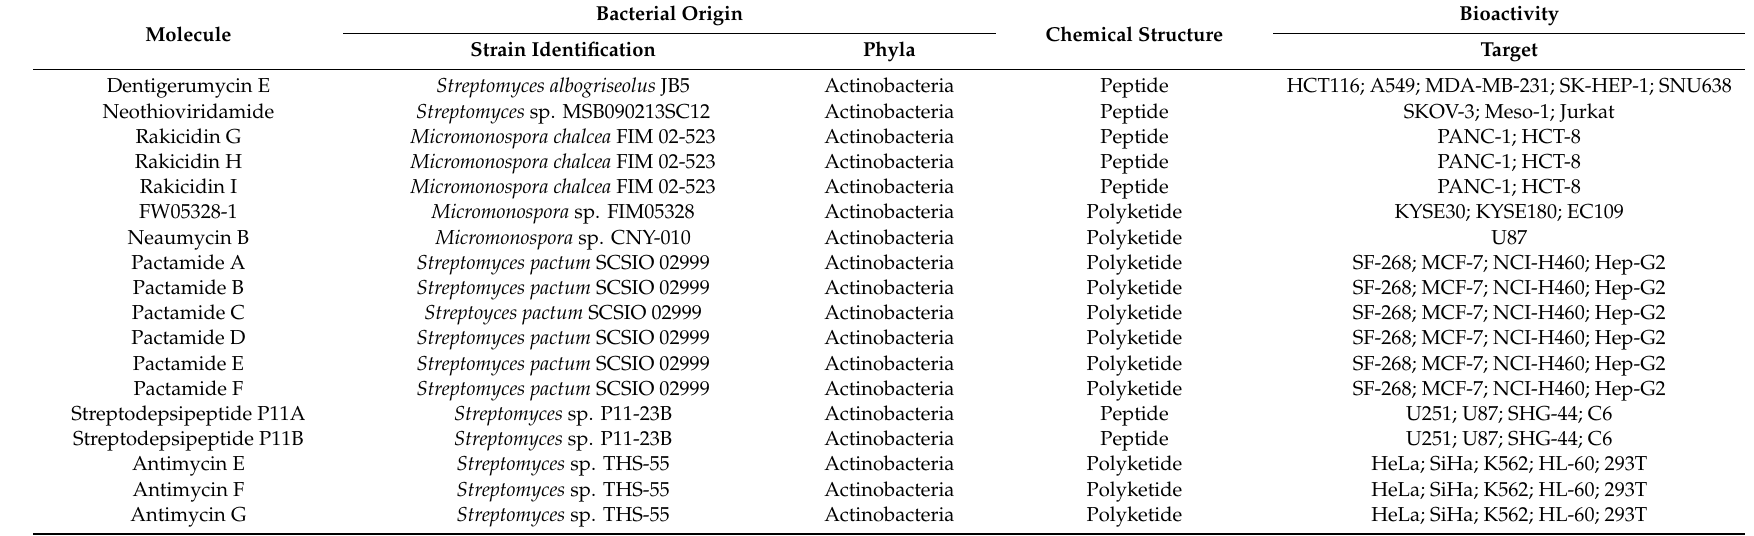
Table 3. Recently isolated bioactive molecules from marine bacteria with cytotoxic